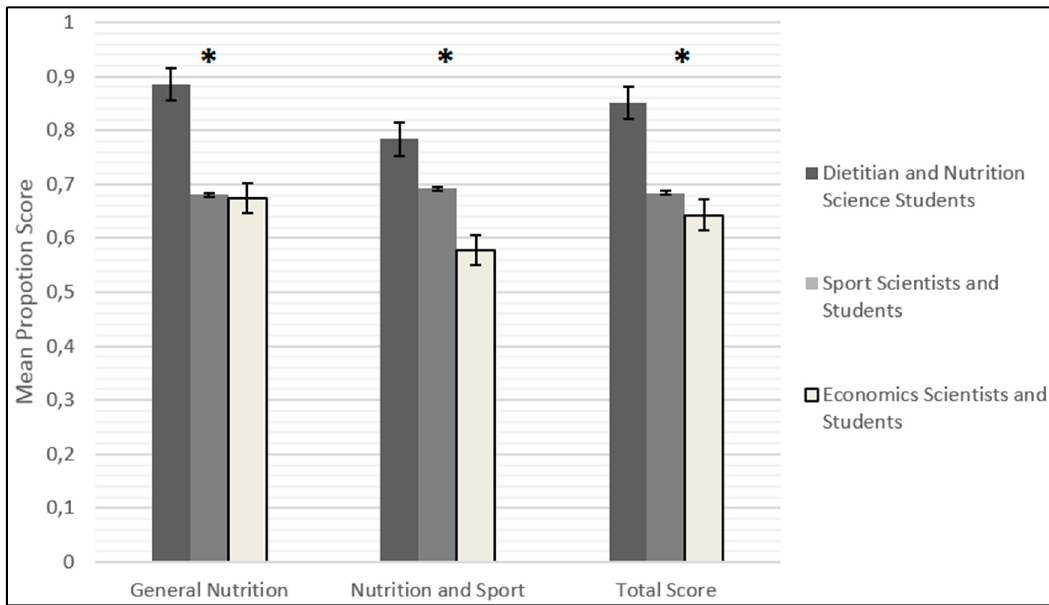
Figure 2. Difference of the mean score of the GeSNK questionnaire among the two groups of experts (Dietitian and Nutrition Science students; Sport Scientists and students) and the control group (Economics Scientists and students). Note: * p <